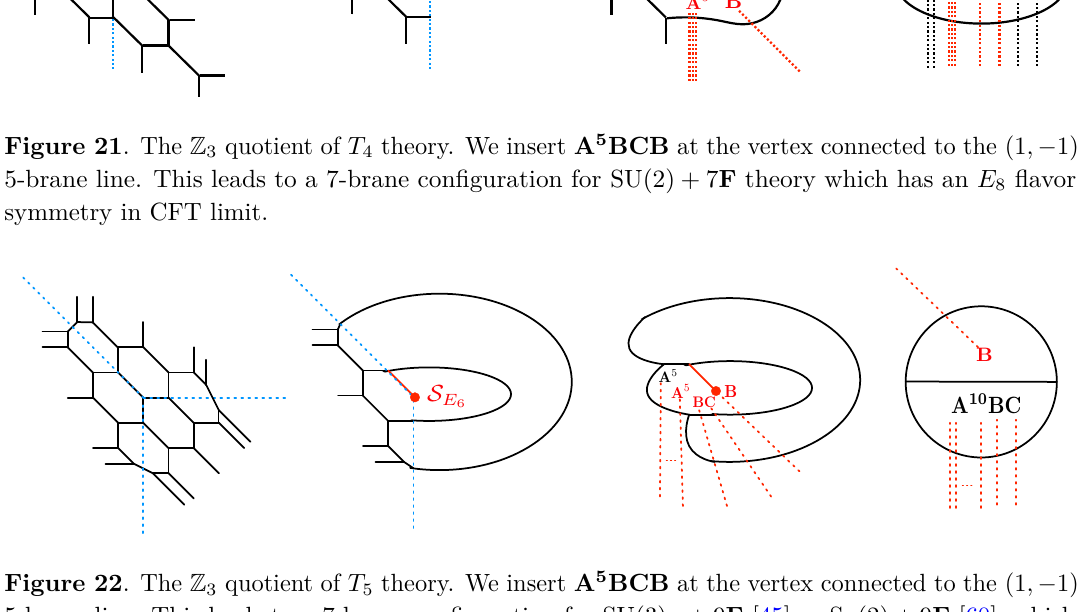
+ 9 F [45] or Sp(2) + 9 F [60], which 1 2